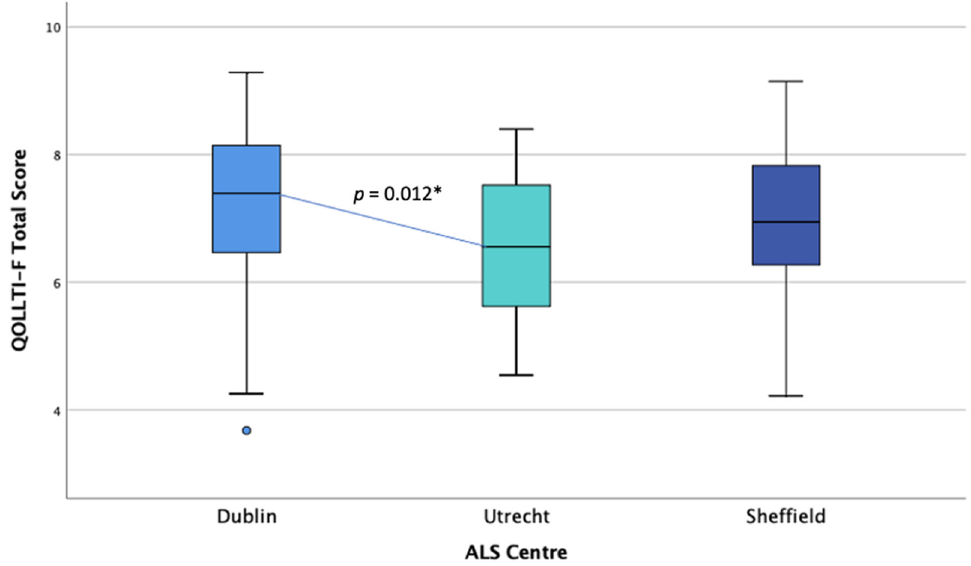
Figure 4. Distribution of quality of life (QOLLTI-F) scores across centres. * Statistical